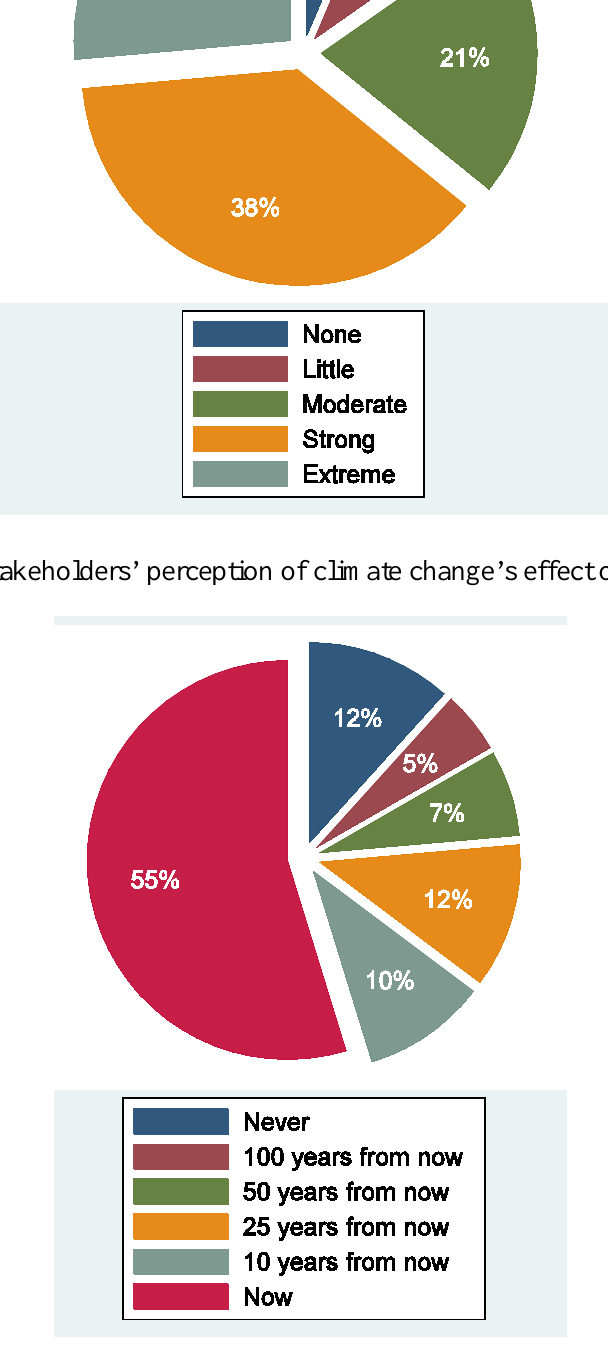
Figure 5. Stakeholders’ perception of the timing of the arrival of climate change impacts in